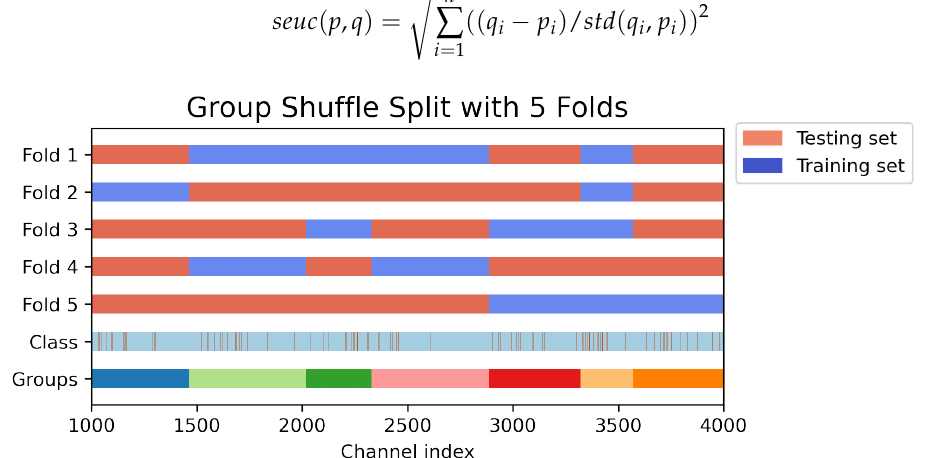
Figure 2. A working example of the group shuffle split cross-validation technique with test size = 50%. The x -axis represents the channel indices. The brown vertical lines in the ‘Class’ row indicate bad channels while the blue background represents good channels. ‘Groups’ indicate the subjects, each containing a different number of sessions. For illustration purposes, we restricted the number of folds to five and the number of subjects (‘Groups’) to seven. Note that in any given fold, no group simultaneously takes part in both training and test sets, thereby avoiding subject-specific data